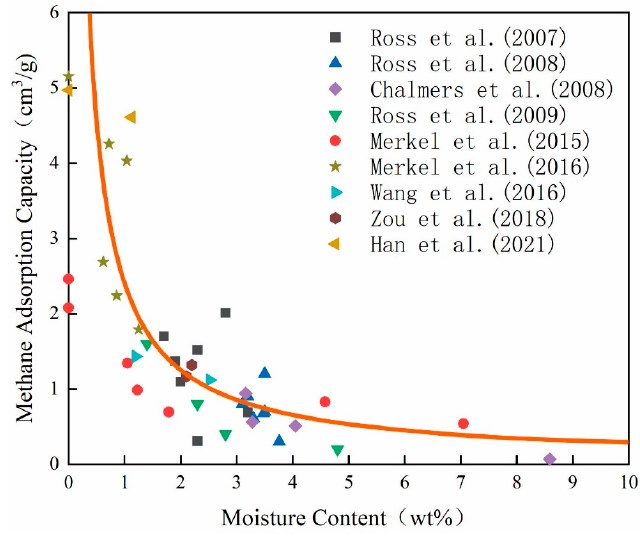
Figure 1. Relationship between equilibrium moisture content and methane absolute adsorption capacity of shales (pressure 6 Mpa, temperature 298–318 K). The data sources are as follows: the Gordondale and Muskwa shales in British Columbia, Canada [5,85]; the Lower Cretaceous shale in northeastern British Columbia, Canada [33]; the D-M shale in British Columbia, Canada [9]; the Bossier, Haynesville, in Texas and Louisiana, USA, and the LOS shales in the Midland Valley Basin, Scotland [28,87]; the Carboniferous Keluke Formation shale in the eastern part of Qaidam Basin, China [88]; the Carynginia Formation shale in the Perth Basin, Western Australia [89]; the Longmaxi shale in the southeastern part of Sichuan Basin, China [96].